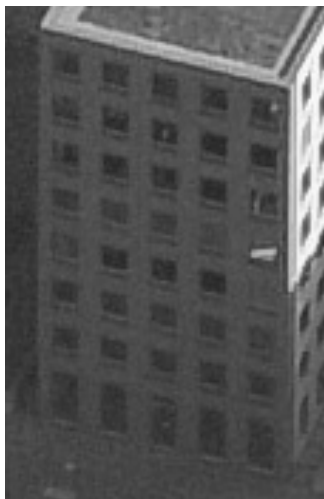
Figure 10. Facade used for fusion example. In the right most window column a reflection is visible.